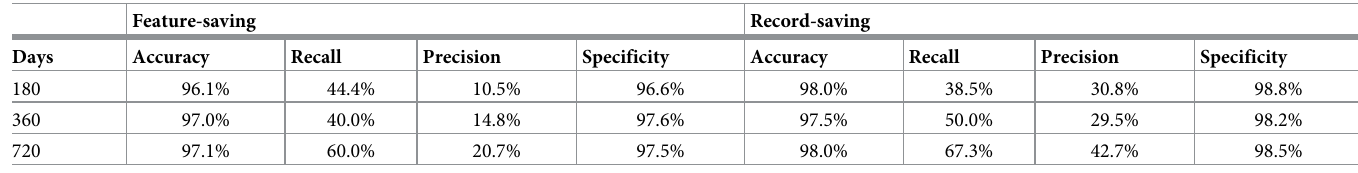
Table 5. Results of History-Oriented setting on Feature-saving and Record-saving datasets at 180, 360 and 720 days.